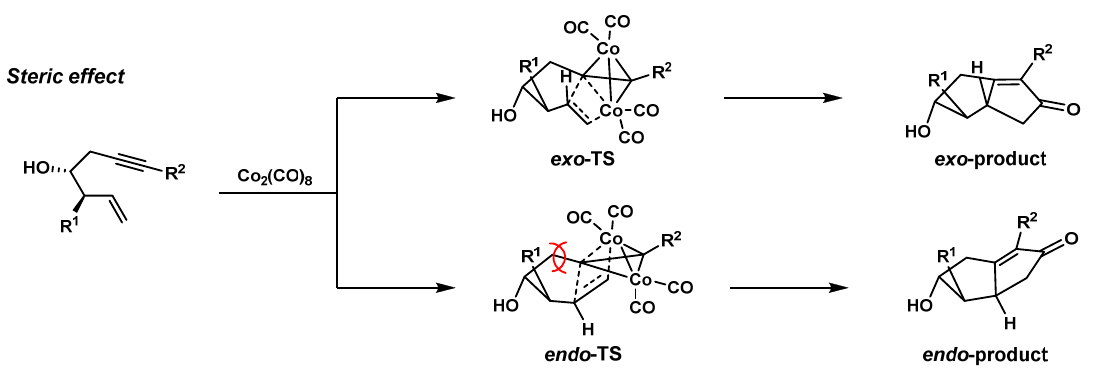
Scheme 3. Diastereoselectivity study of intramolecular Pauson-Khand reaction.